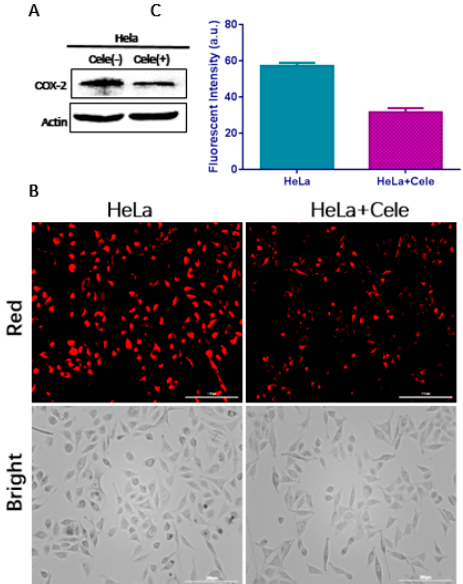
Figure 7. COX-2 inhibitory effect. ( A ) Western blot showing COX-2 expression level of HeLa cells treated with COX-2 inhibitors (Cele = Celecoxib), which revealed that celecoxib inhibited COX-2 expression. ( B ) fluorescent microscopy images with treatment of CCY-5 (1 μ M) for 30 min ( λ ex: 628 nm; Red, λ em: 685 nm; All the images share the same scale bar: 200 μ m). ( C ) Quantitative image analysis of the average total fluorescence intensity of HeLa cells (n = 3). * p < 0.05.